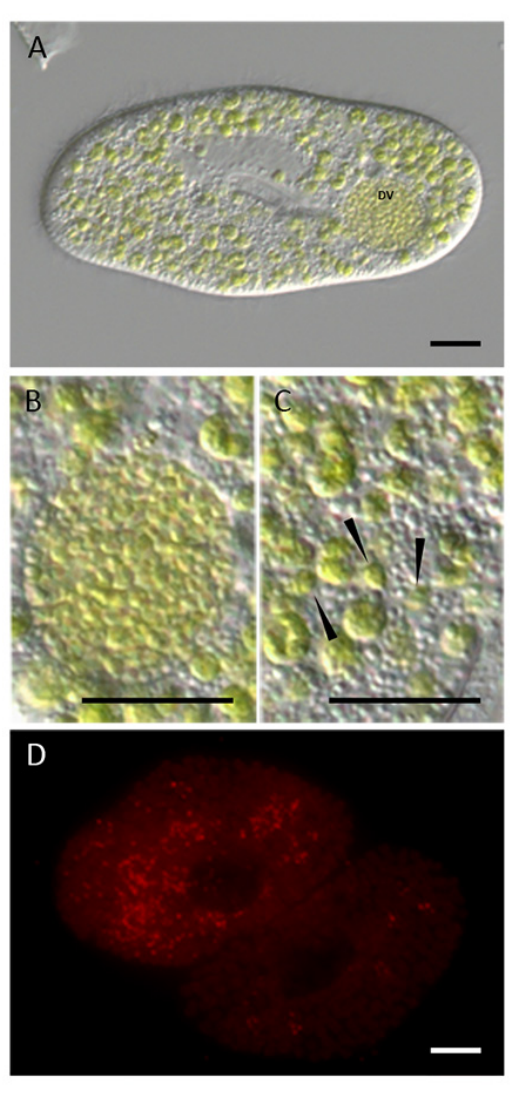
Figure 2. Paramecium bursaria and its intracellular algae. ( A ) P. bursaria cell of strain Frieds with micro- and picoalgae distributed throughout the cytoplasm. ( B ) Digestive vacuole of the same cell incorporating multiple picoalgae. ( C ) Micro- and picoalgae simultaneously situated within the host’s cytoplasm. Arrows indicate intracellular picoalgae. ( D ) Autofluorescence signal of the chloroplast from intracellular picoalgae of P. bursaria strain Frieds. Scale bars: 20 µ